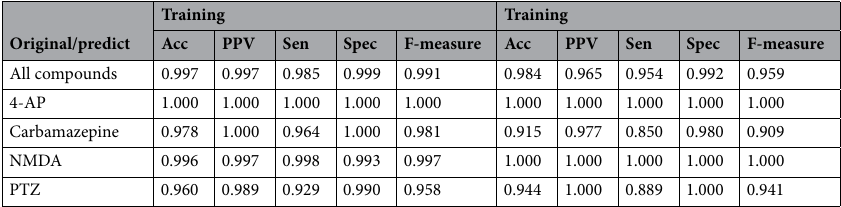
Table 2. Predictive model performance evaluation using the optimum operating point. Acc accuracy, PPV positive predictive value, Sen sensitivity, Spec specificity.